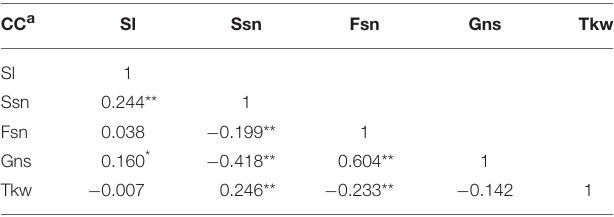
TABLE 2 | Analysis of variance results and broad-sense heritabilities for spike traits in DH populations from two locations in 2 years. Trait